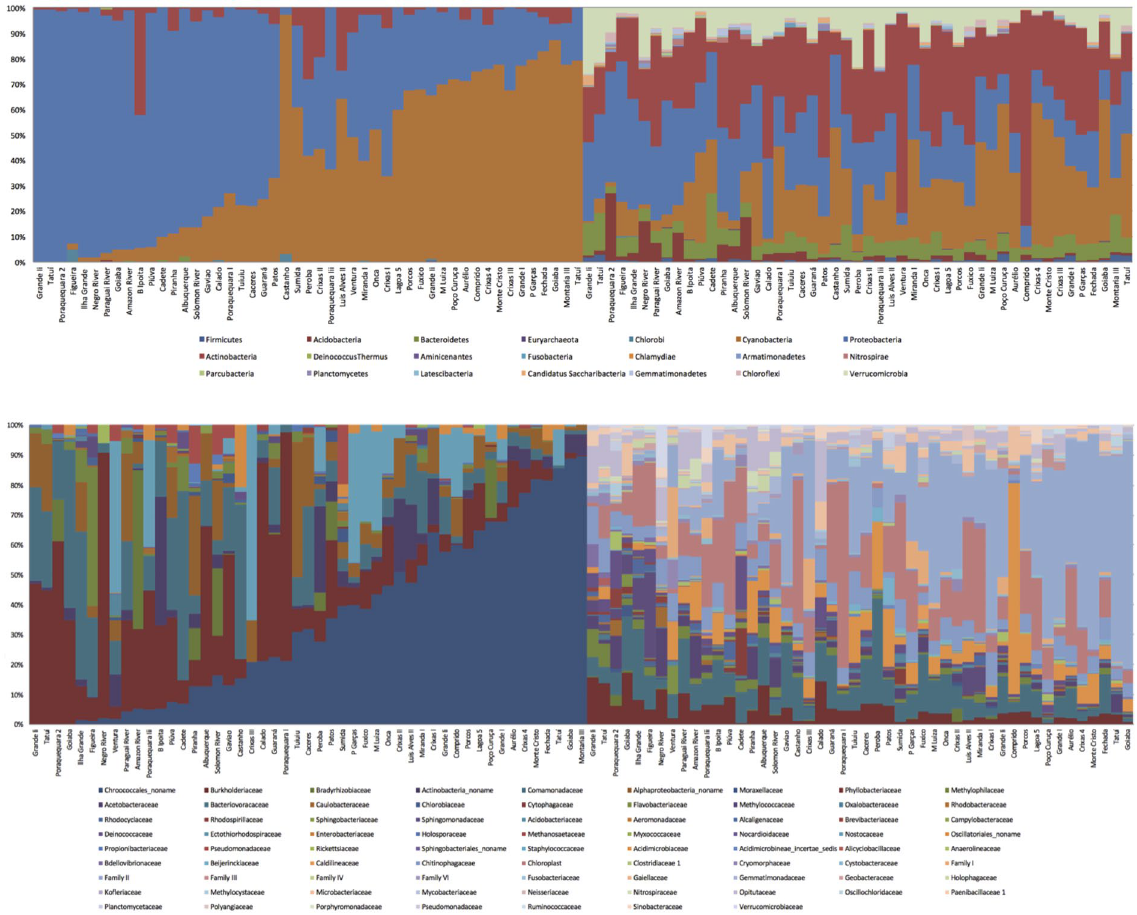
Figure 1. Bar plots showing the proportion of reads of the 49 samples in this study at the phylum (top) and family (bottom) levels, comparing the shotgun (left) and amplicon (right) techniques. The samples in both phylum-level and family-level panels are sorted on the percentage of Proteobacteria and Cyanobacteria Family II, respectively, in the shotgun data